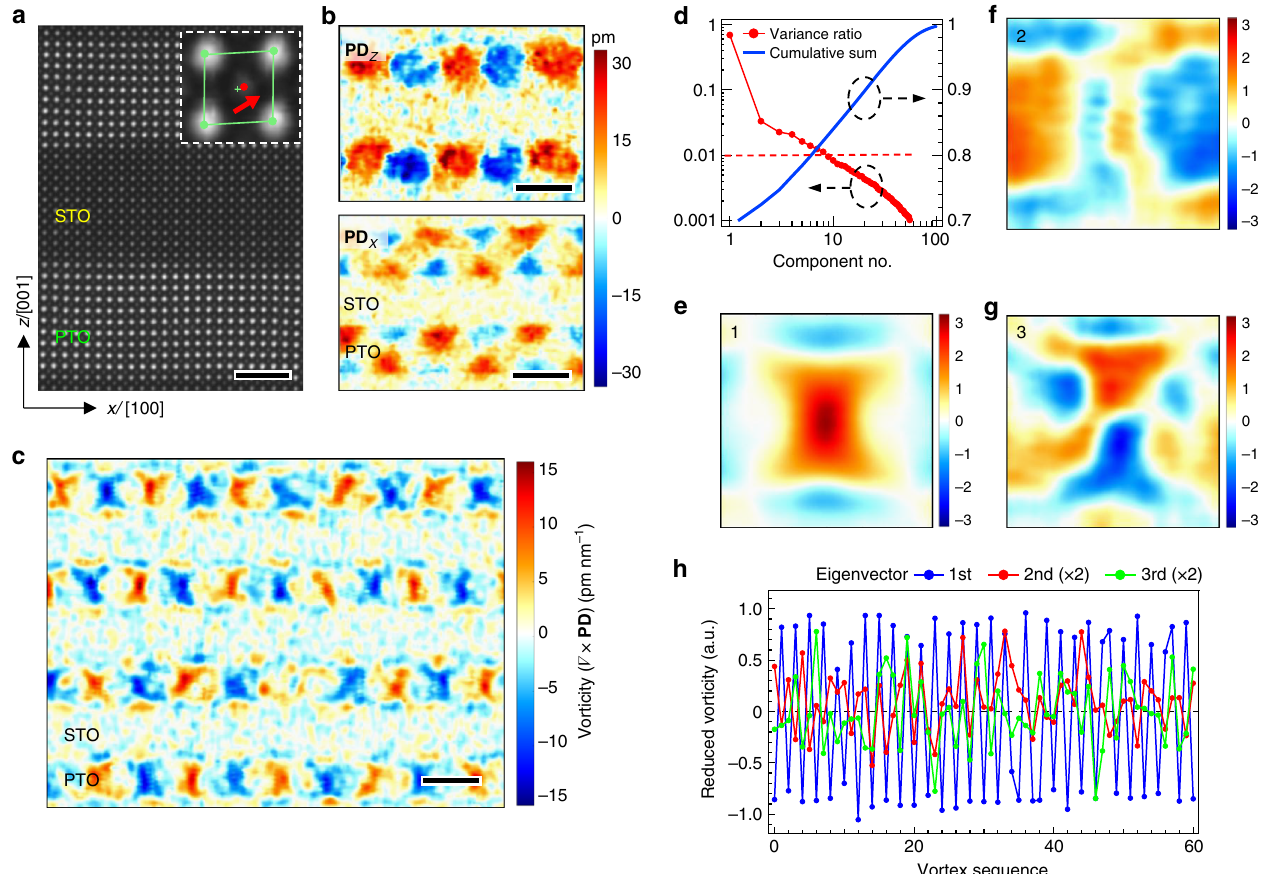
Fig. 1 Multivariate analysis of the observed polar vortex patterns. a Typical atomic-resolution high-angle annular dark- fi eld (HAADF) STEM image of (PTO) 10 /(STO) 10 superlattices. Inset is a zoom-in view of a single unit cell with the Pb/Ti atom positions denoted by green/red dots and the center-of- mass position of the Pb sublattice by a green cross; from their relative shift, the polar displacement ( PD ) vector can be derived as denoted by a red arrow. Scale bar, 2 nm. b The z / x -components of the PD vector fi eld for a selected sample region. Scale bar: 5 nm. c Typical experimental vortex patterns represented by the vorticity calculated from the PD vector fi eld. Scale bar, 5 nm. d – h Selected PCA results of the entire vortex dataset, of which d is the explained variance ratio for ~60 principal components, e – g are the fi rst three components (loading map size: 5.4 × 5.4 nm 2 ) and the corresponding eigenvectors are shown in h with the ordinates